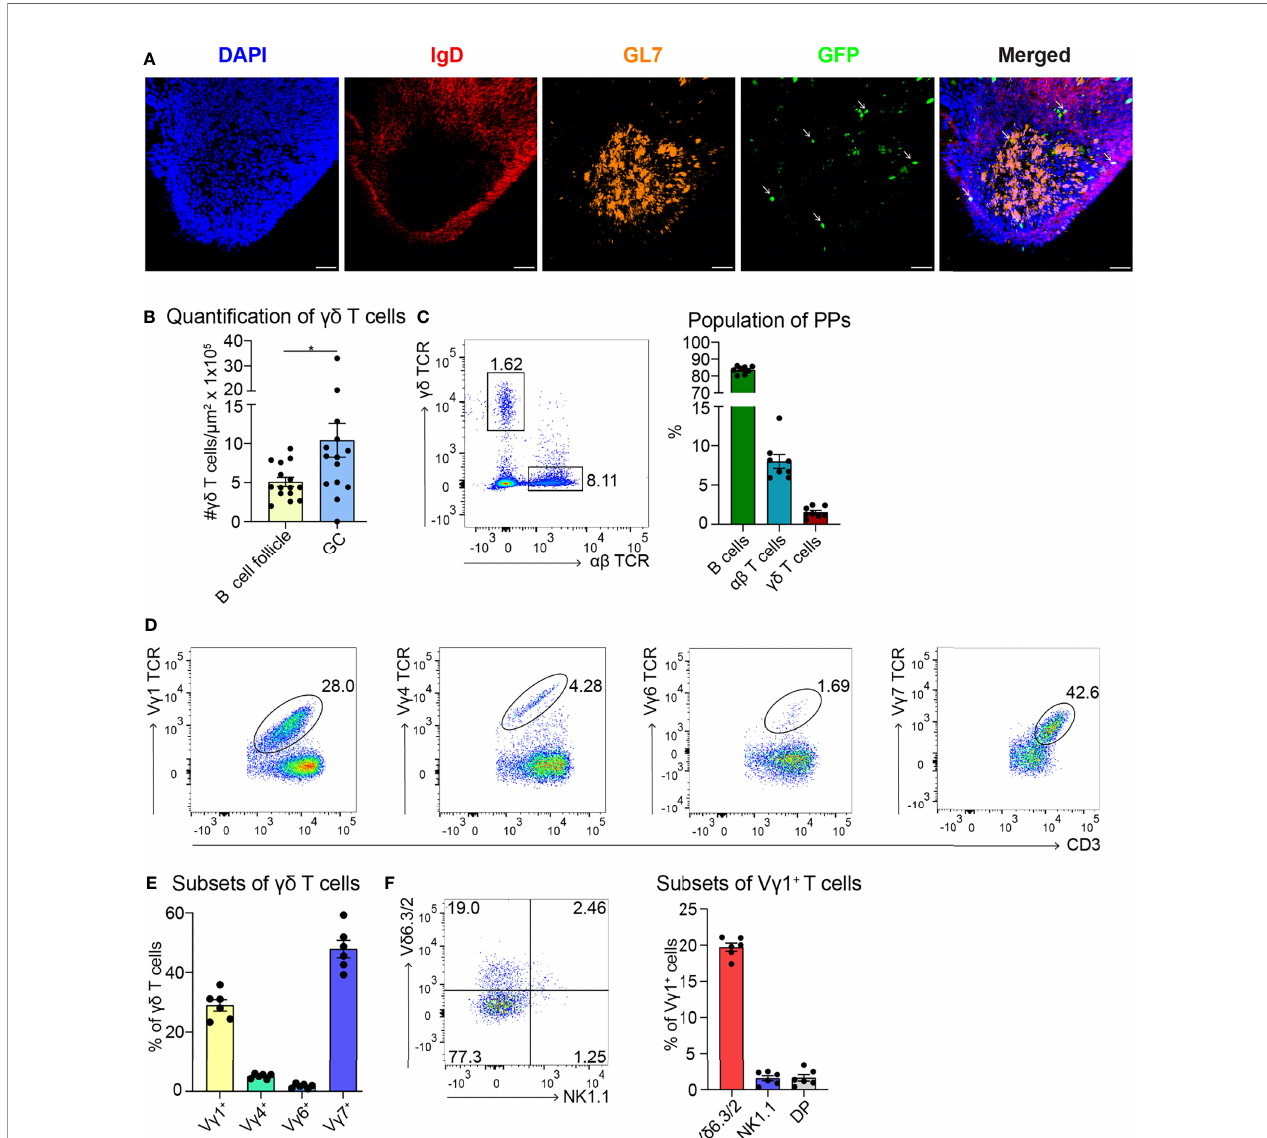
FIGURE 1 | Most of the gd T cells localize in GCs of PPs and express the V g 1 + TCR. (A) Confocal fl uorescence microscopy of frozen sections of PPs from Tcrd -H2BeGFP mice stained with anti-IgD (red), anti-GL7 (orange), and DAPI (blue) to detect the nuclei. GFP-expressing gd T cells (green) are highlighted with an arrow. Scale bar, 50 µm. (B) gd T cells inside the B cell follicles (IgD + ) and germinal centers (GC; IgD − , GL7 + ) were quanti fi ed. For the quanti fi cation, sections of PPs were analyzed from different mice. Each dot represents an individual cut. Bar graph, mean ± SEM. n = 5 mice. (C) FACS analysis of B cells (CD19 + , TCR b − ), ab T cells (CD19 − , CD3 + , TCR b + ), gd T cells (CD19 − , CD3 + , GFP + ) in PPs from Tcrd -H2BeGFP mice. Bar graph, mean ± SEM. n = 8. (D) FACS analysis of V g 1 TCR, V g 4 TCR, V g 6 TCR, and V g 7 TCR gated on gd T cells (TCR b − , CD3 + , GFP + ) of PPs from Tcrd -H2BeGFP mice. (E) Quanti fi cation of V g 1 TCR, V g 4 TCR, V g 6 TCR, and V g 7 TCR expressed on gd T cells (TCR b − , CD3 + , GFP + ) of PPs from Tcrd -H2BeGFP mice. Bar graph, mean ± SEM. n = 6. (F) FACS analysis of V d 6.3/2, and NK1.1 gated on V g 1 + T cells (TCR b − , CD3 + , GFP + , V g 1 TCR + ) of PPs from Tcrd -H2BeGFP mice. Bar graph, mean ± SEM. n = 6. Each dot represents an individual mouse. *P <